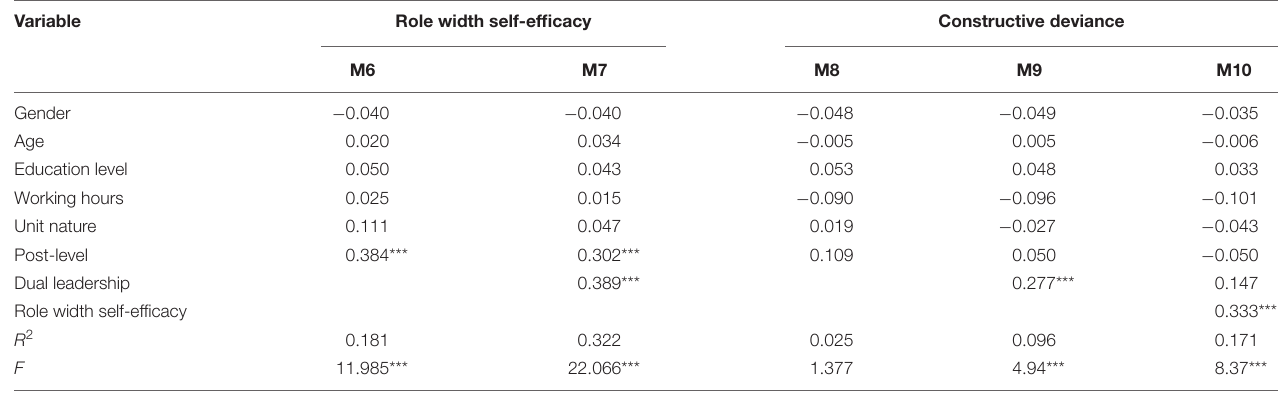
TABLE 5 | Intermediary test of role width self-efficacy. Variable